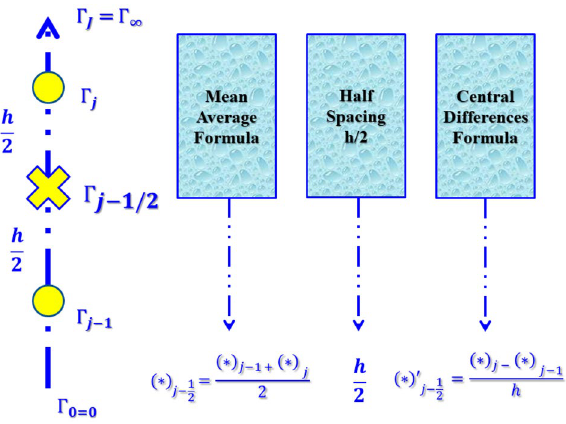
Figure 4. The rectangular grid of difference